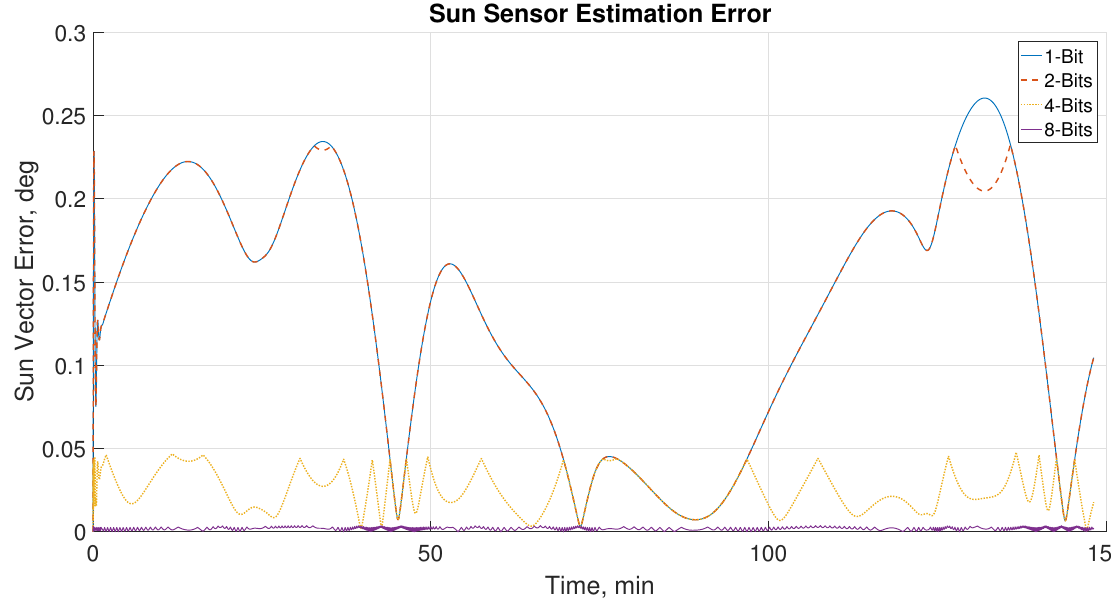
Figure 13. Sun sensor error for the test orbit at 1-, 2-, 4- and 8-bit readout